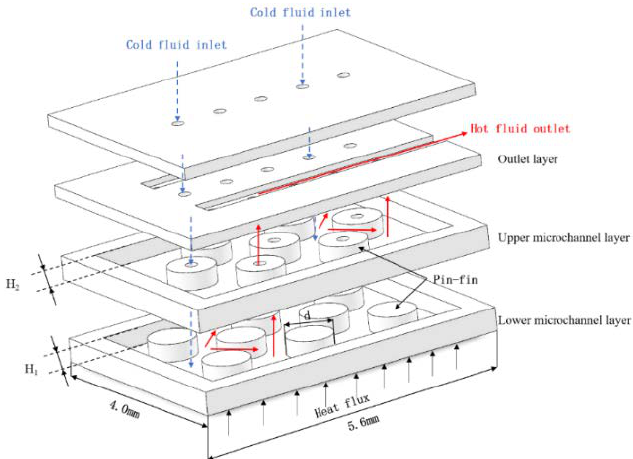
Figure 2. The structure of the double-layer pin–fin MMC.